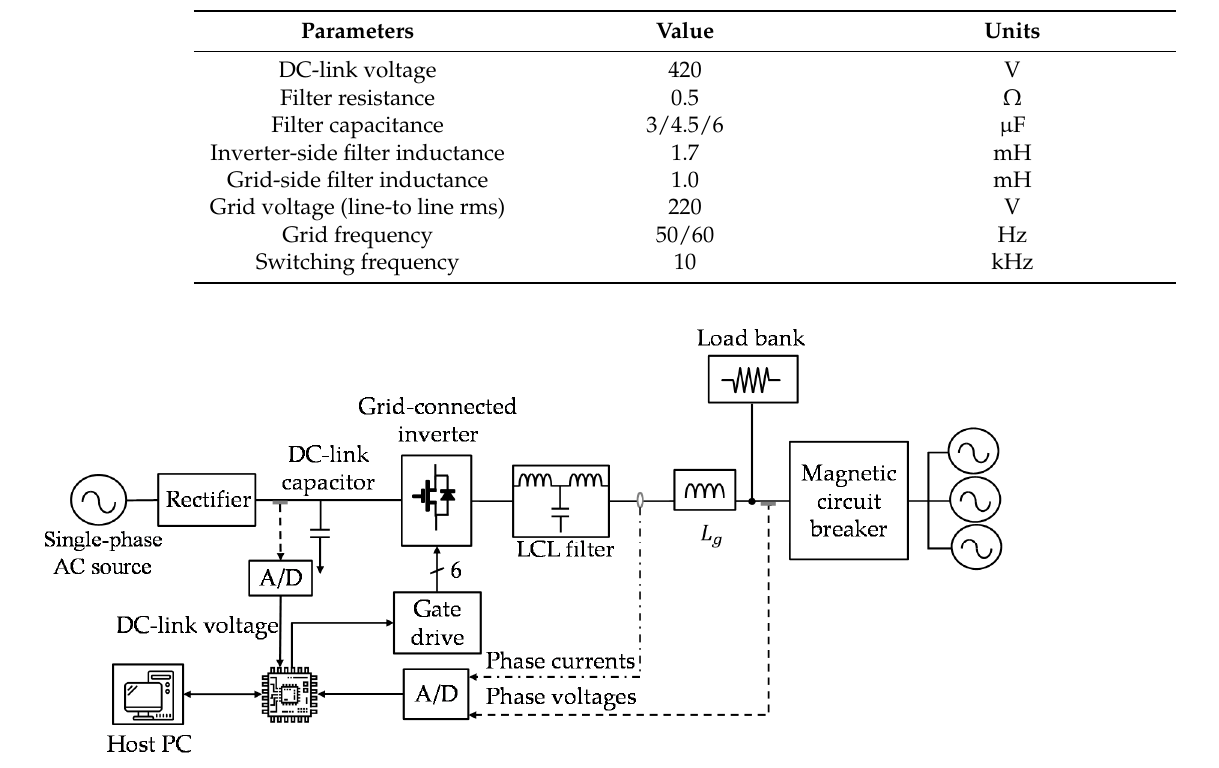
Table 1. System parameters of a three-phase GCI with LCL filter.